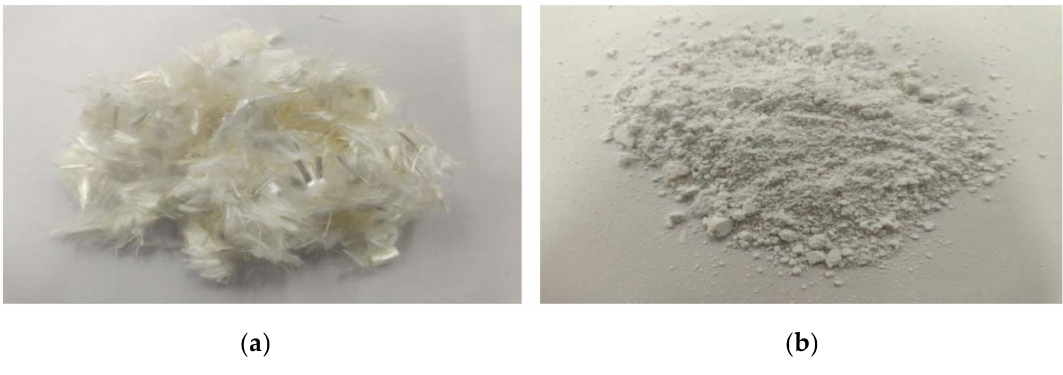
Figure 1. ( a ) Polyvinyl alcohol fiber; ( b ) silica fume. Table 1. Detailed parameters of silica fume and polyvinyl alcohol